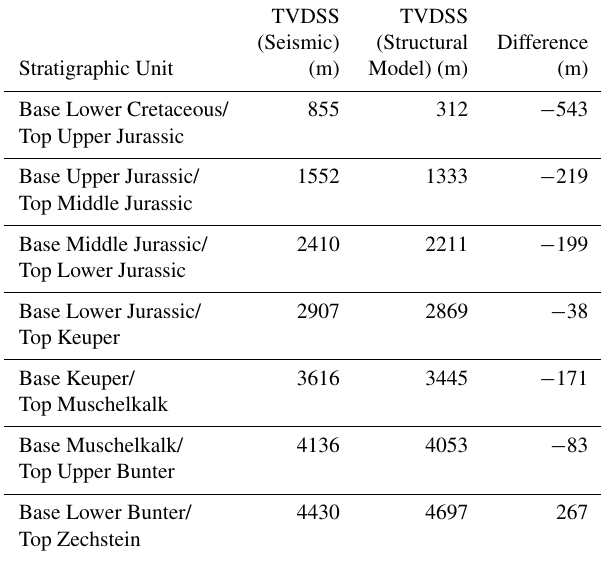
Table 6. Comparison between the depth converted stratigraphic boundaries of seismic line RHBGOSTO U940999 and the con- structed structural geological model (TVDSS = true vertical depth sub-sea). A negative difference indicates an overestimation of the seismic velocities whereas a positive difference indicates an under- estimation of the seismic velocities. TVDSS TVDSS (Seismic) (Structural Difference Stratigraphic Unit Model)